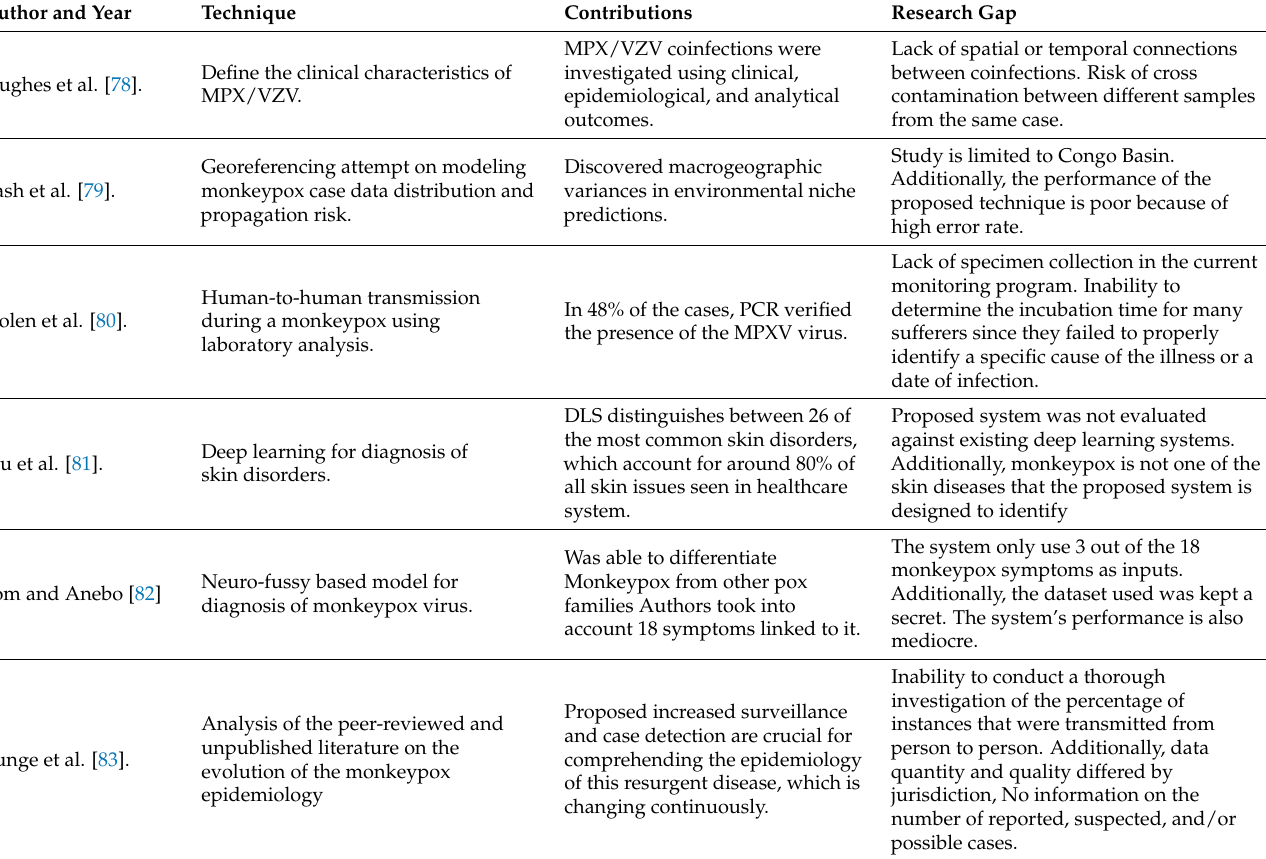
Table 1. Summary of Related